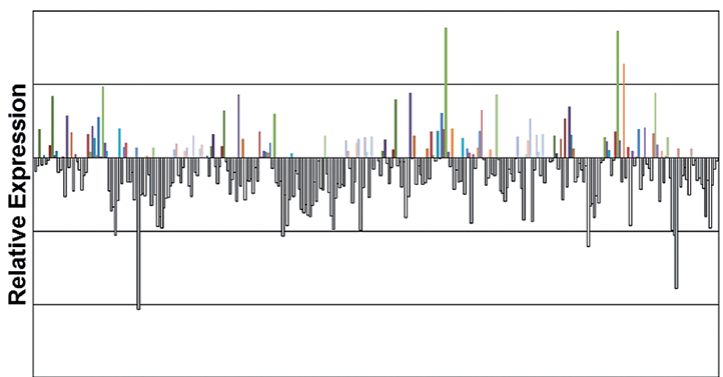
Figure 1 - Expression levels of the four genes in PCa tissue compared to BPH. Fold change in expression was calculated using the 2- ∆∆ CT